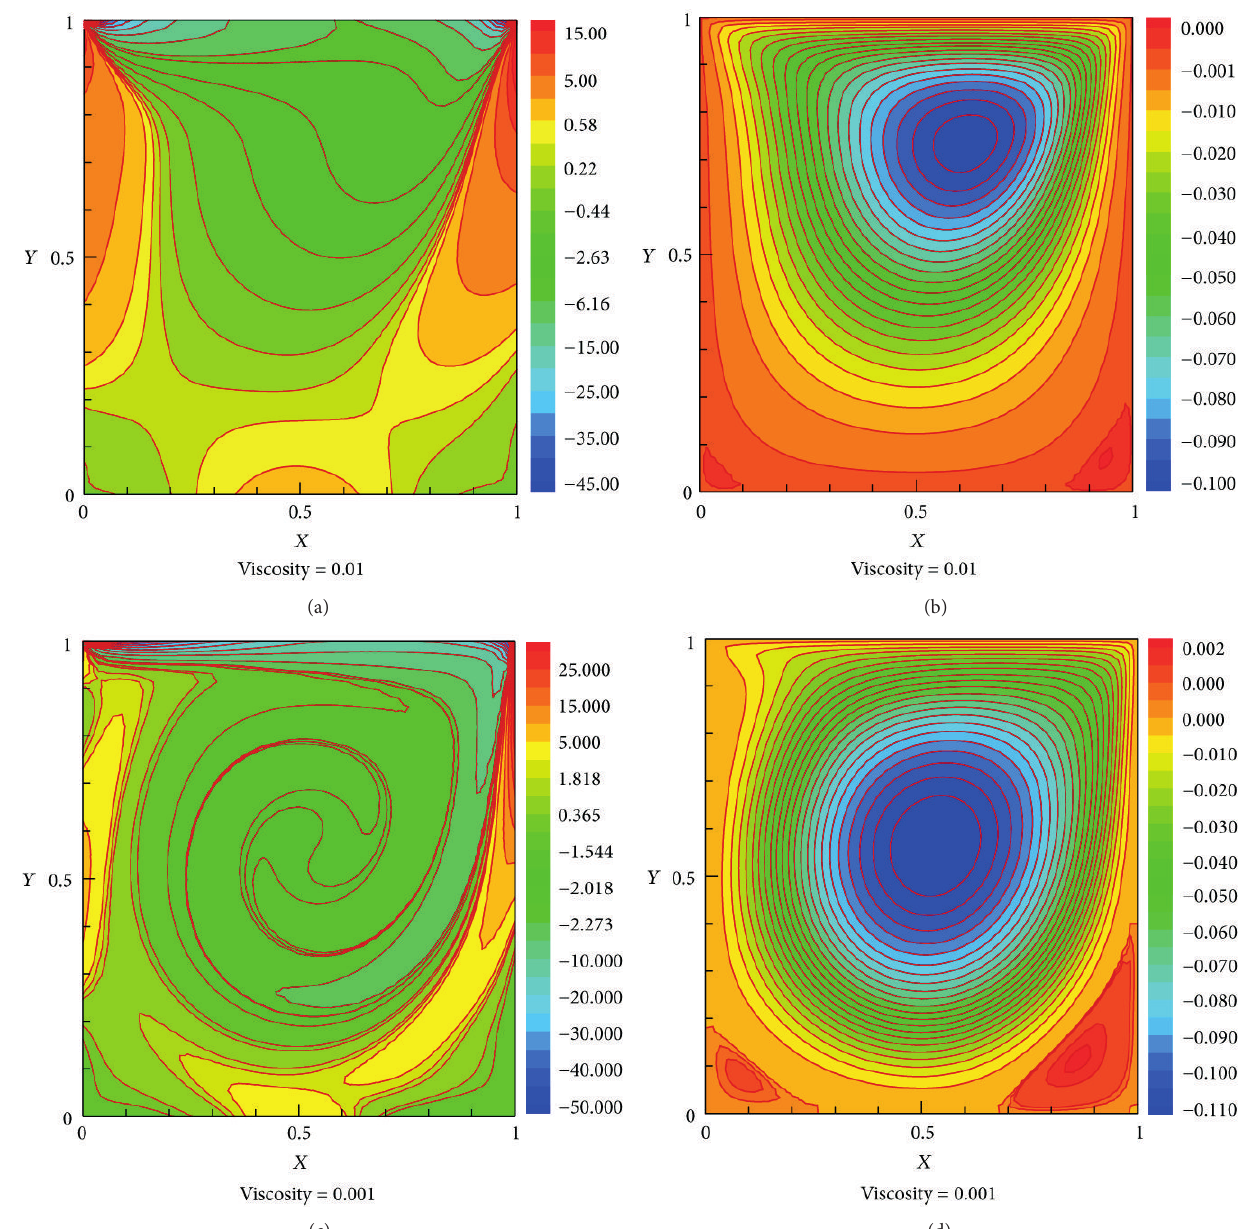
Figure 8: Mean values of vorticity ((a) and (c)) and stream function ((b) and (d)) for 𝑃 = 2 and 𝑀 = 2